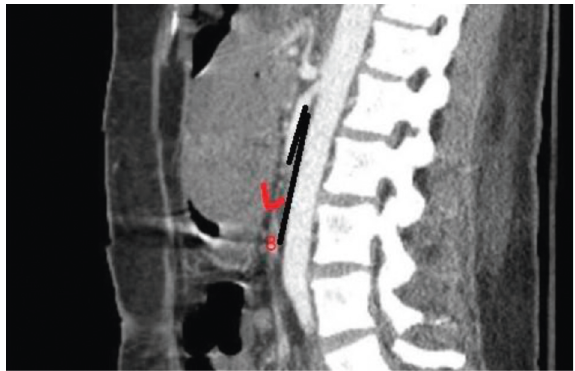
Figure 1: CT sagittal view showing an angle of 8 degrees between the superior mesenteric artery and aorta.